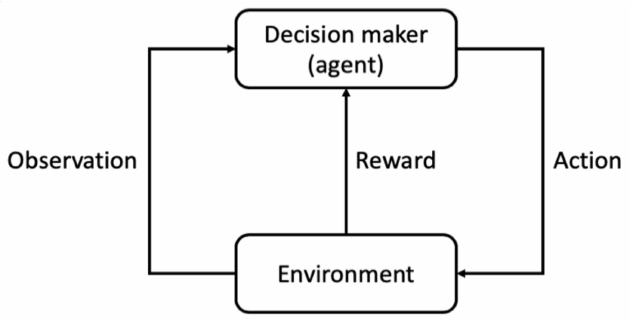
Figure 5. Reinforcement learning (RL) agent and the environment interaction.